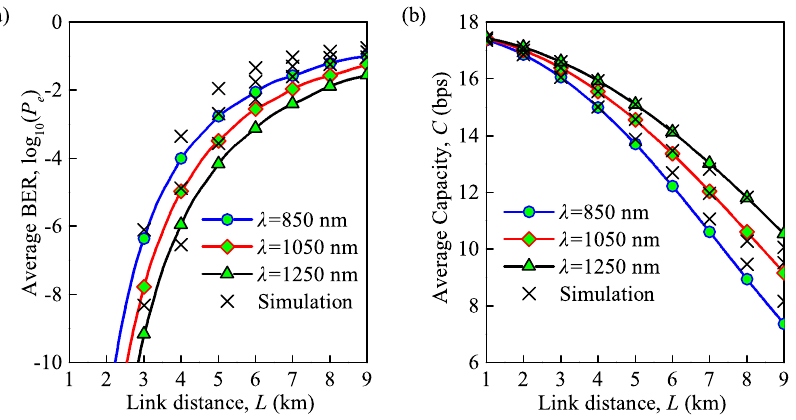
Figure 3. ( a ) Average BER versus link distance for different wavelengths; ( b ) average capacity versus link distance for different wavelengths ( C 2 n = 0.35 × 10 − 14 m − 2/3 for weak turbulence, T e = 300 K, R b = 0.155